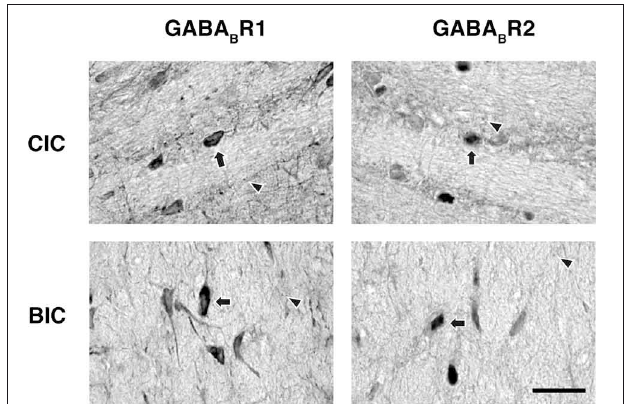
FIGURE 10 | Photomicrographs showing GABA B R1 and GABA B R2 immunoreactivity in the CIC and BIC regions. Arrows point toward labeled cell bodies while arrowheads point toward labeled puncta in the neuropil. Scale bars: 25 μ m.